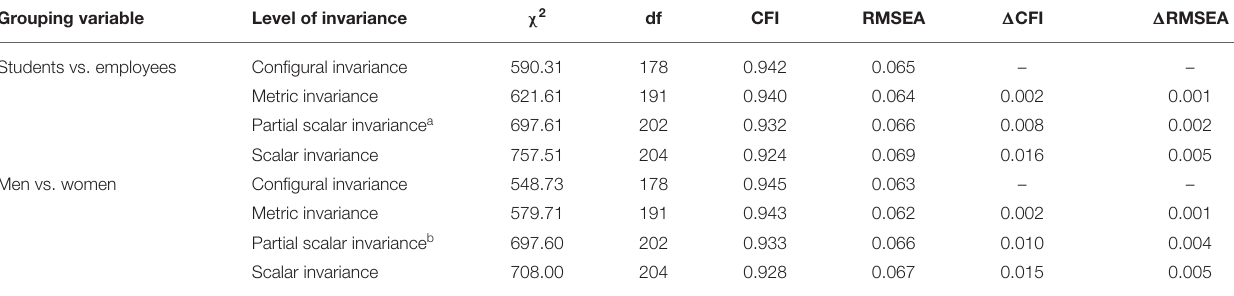
TABLE 3 | Global fit measures in measurement invariance tests for the DFPS-PL. Grouping variable Level of invariance χ 2 df CFI RMSEA Students vs.